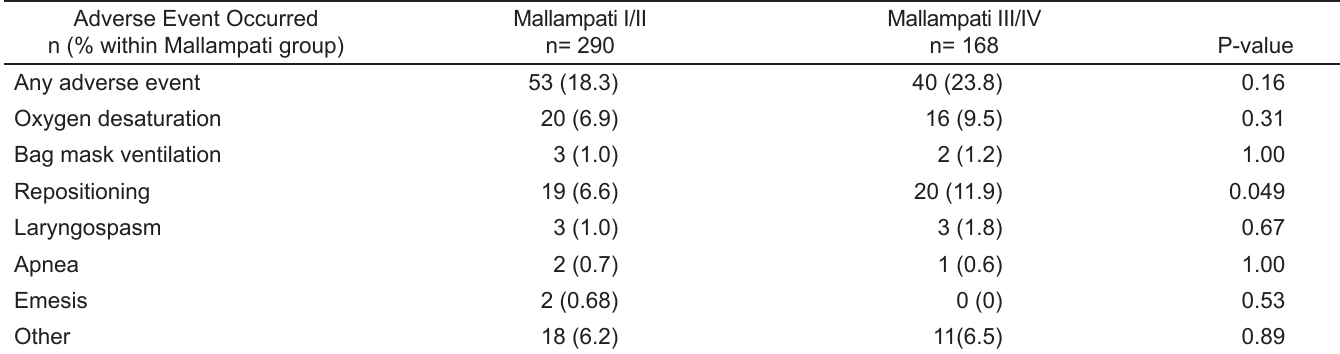
Table 2. Adverse events by Mallampati